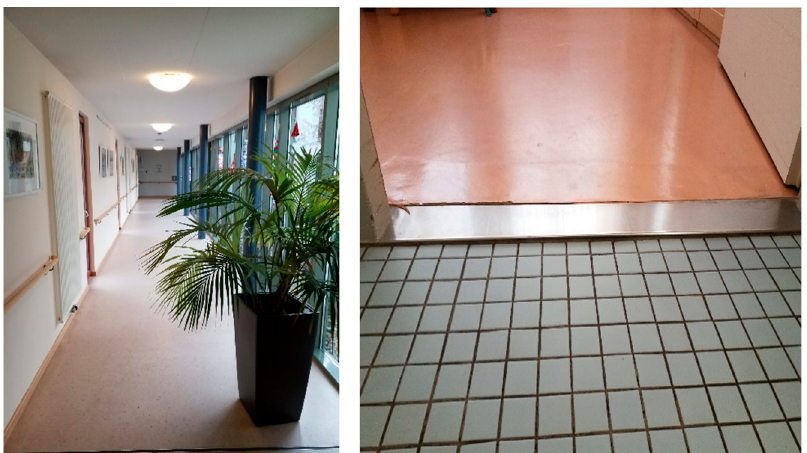
Figure 1. Examples of photographs on the implementation of norm standards vs. not standard conforming building.